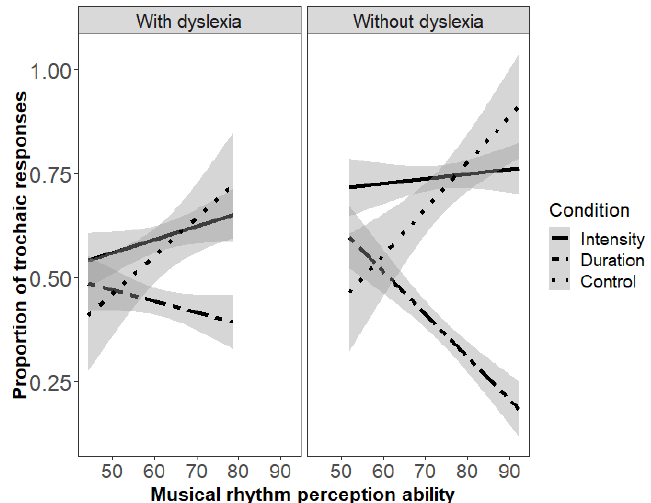
Figure 2. Linear regression lines illustrating the effects of musical rhythm perception ability (Musical Ear Test scores) on rhythmic grouping in the three acoustic conditions separated by group (left panel: with dyslexia, right panel: without dyslexia).